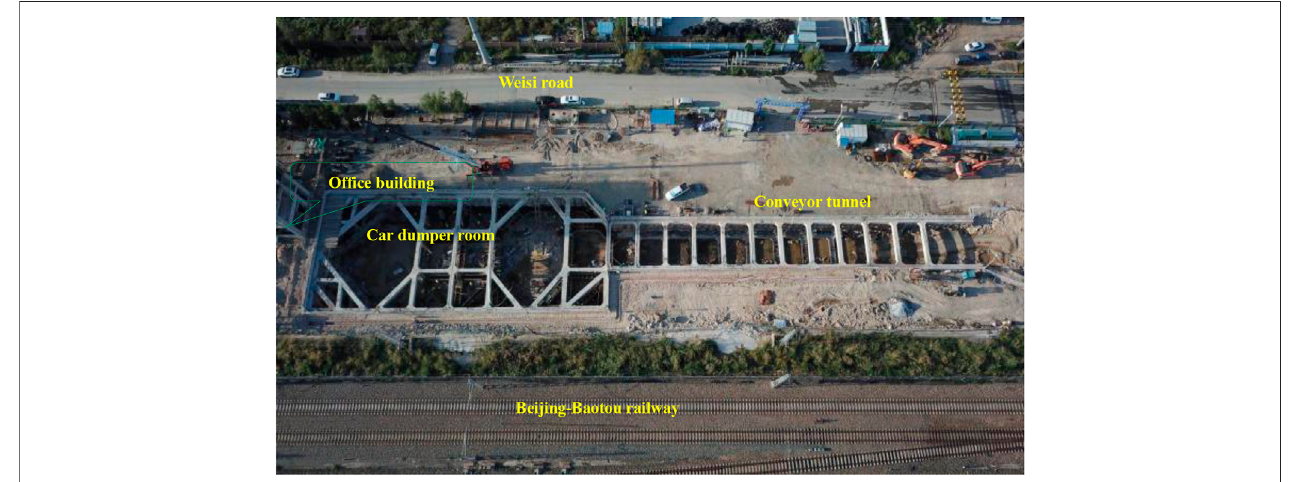
FIGURE 1 | Surrounding environment of the foundation pit.